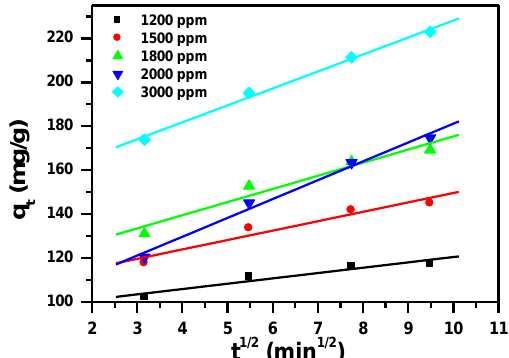
Figure 9. Pseudo-second order plot for the effect of initial dye concentration and contact time on removal of MB using MNS-4.